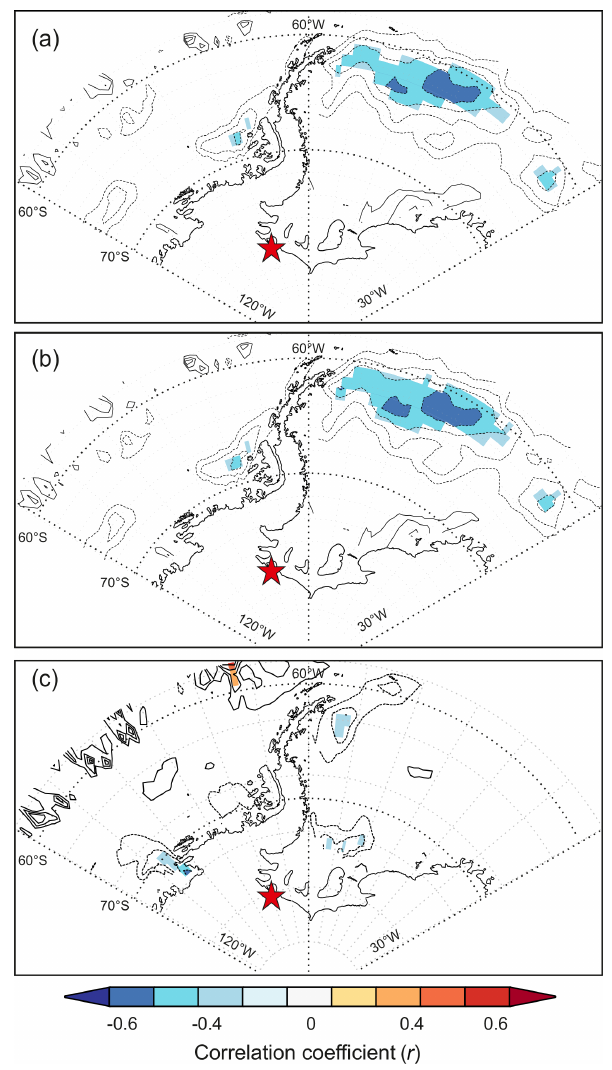
Figure 12. Spatial correlations ( r ) of mean annual sea ice concen- trations in the Weddell and Bellingshausen Sea sectors with stan- dardized mean annual (a) δ 18 O, (b) d excess and (c) snow ac- cumulation in the UG region (red star) for the period 1980–2014 (excluding firn core GUPA-1). For the calculations all time series were detrended and December–November annual averages (calen- dar year) were considered. Only statistically significant correlations ( p < 0 . 05) are